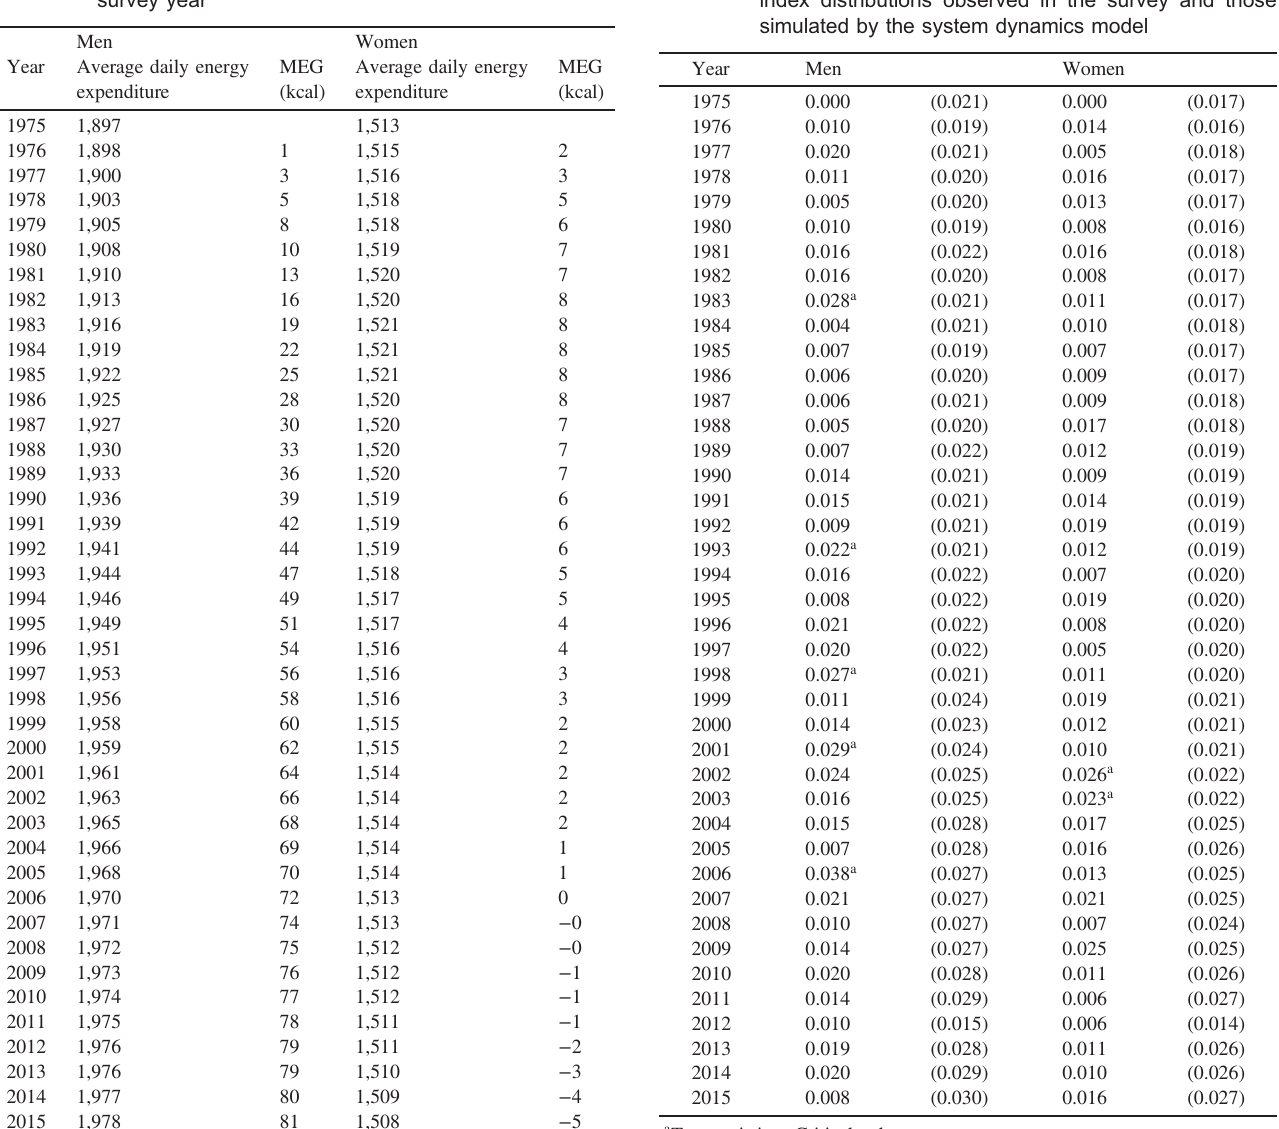
Table 2. Estimated average daily energy expenditure and MEG in Japanese adults aged 20 to 74 years, by sex